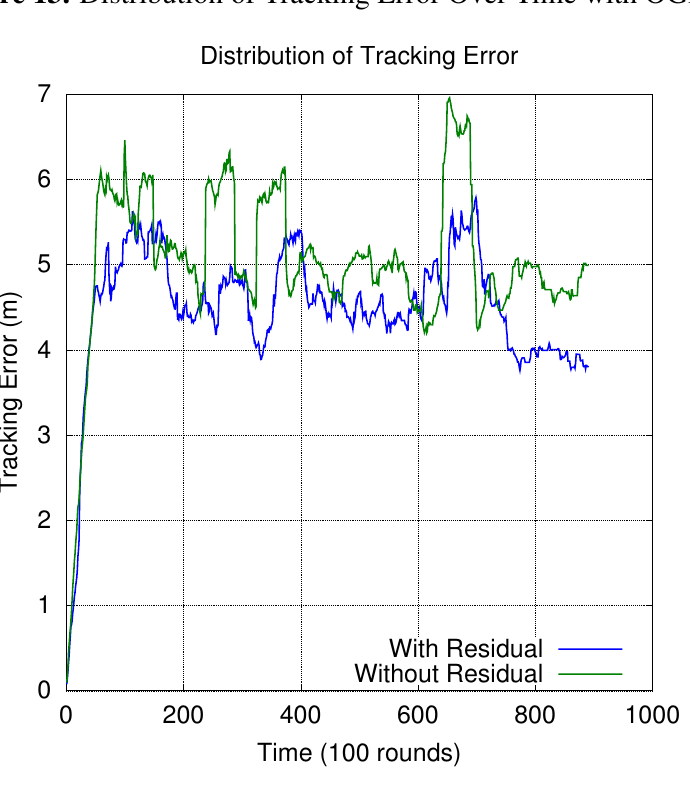
Figure 13. Distribution of Tracking Error Over Time with OGDC.